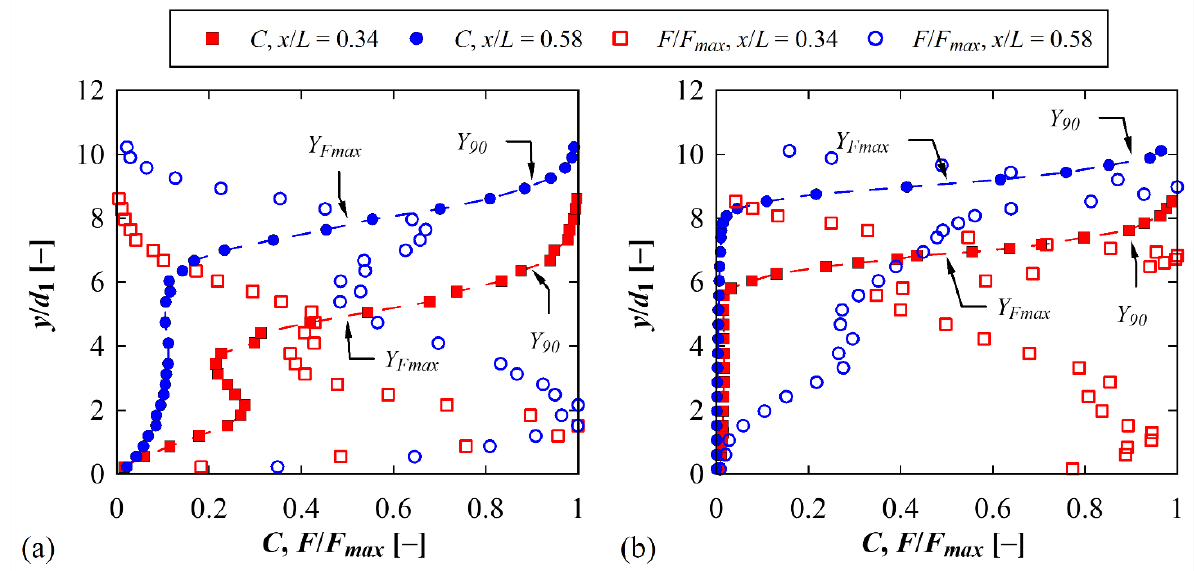
Figure 7. Distributions of void fraction C and particle count rate F at x / L = 0.34 and 0.58: ( a ) without super-cavitating blocks, q = 0.15 m 2 /s, Fr 1 = 8.7, Re = 1.5 × 10 5 ; ( b ) with blocks, q = 0.19 m 2 /s, Fr 1 = 6.7, Re = 1.9 × 10 5 .